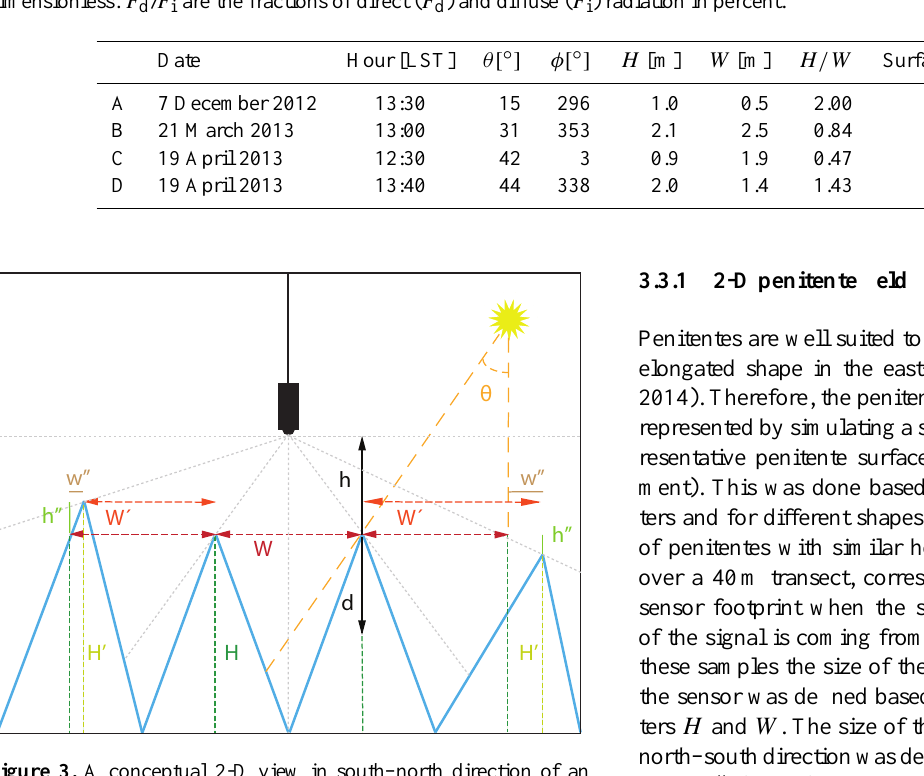
Table 1. Details of the individual experiments. θ is the solar zenith angle and φ the sun’s azimuth angle during the experiment, H is the penitente height (tip to trough) of the trough below the sensor, W the distance between the nearest penitente tips. The ratio H/W is dimensionless. F d / F i are the fractions of direct ( F d ) and diffuse ( F i ) radiation in percent.